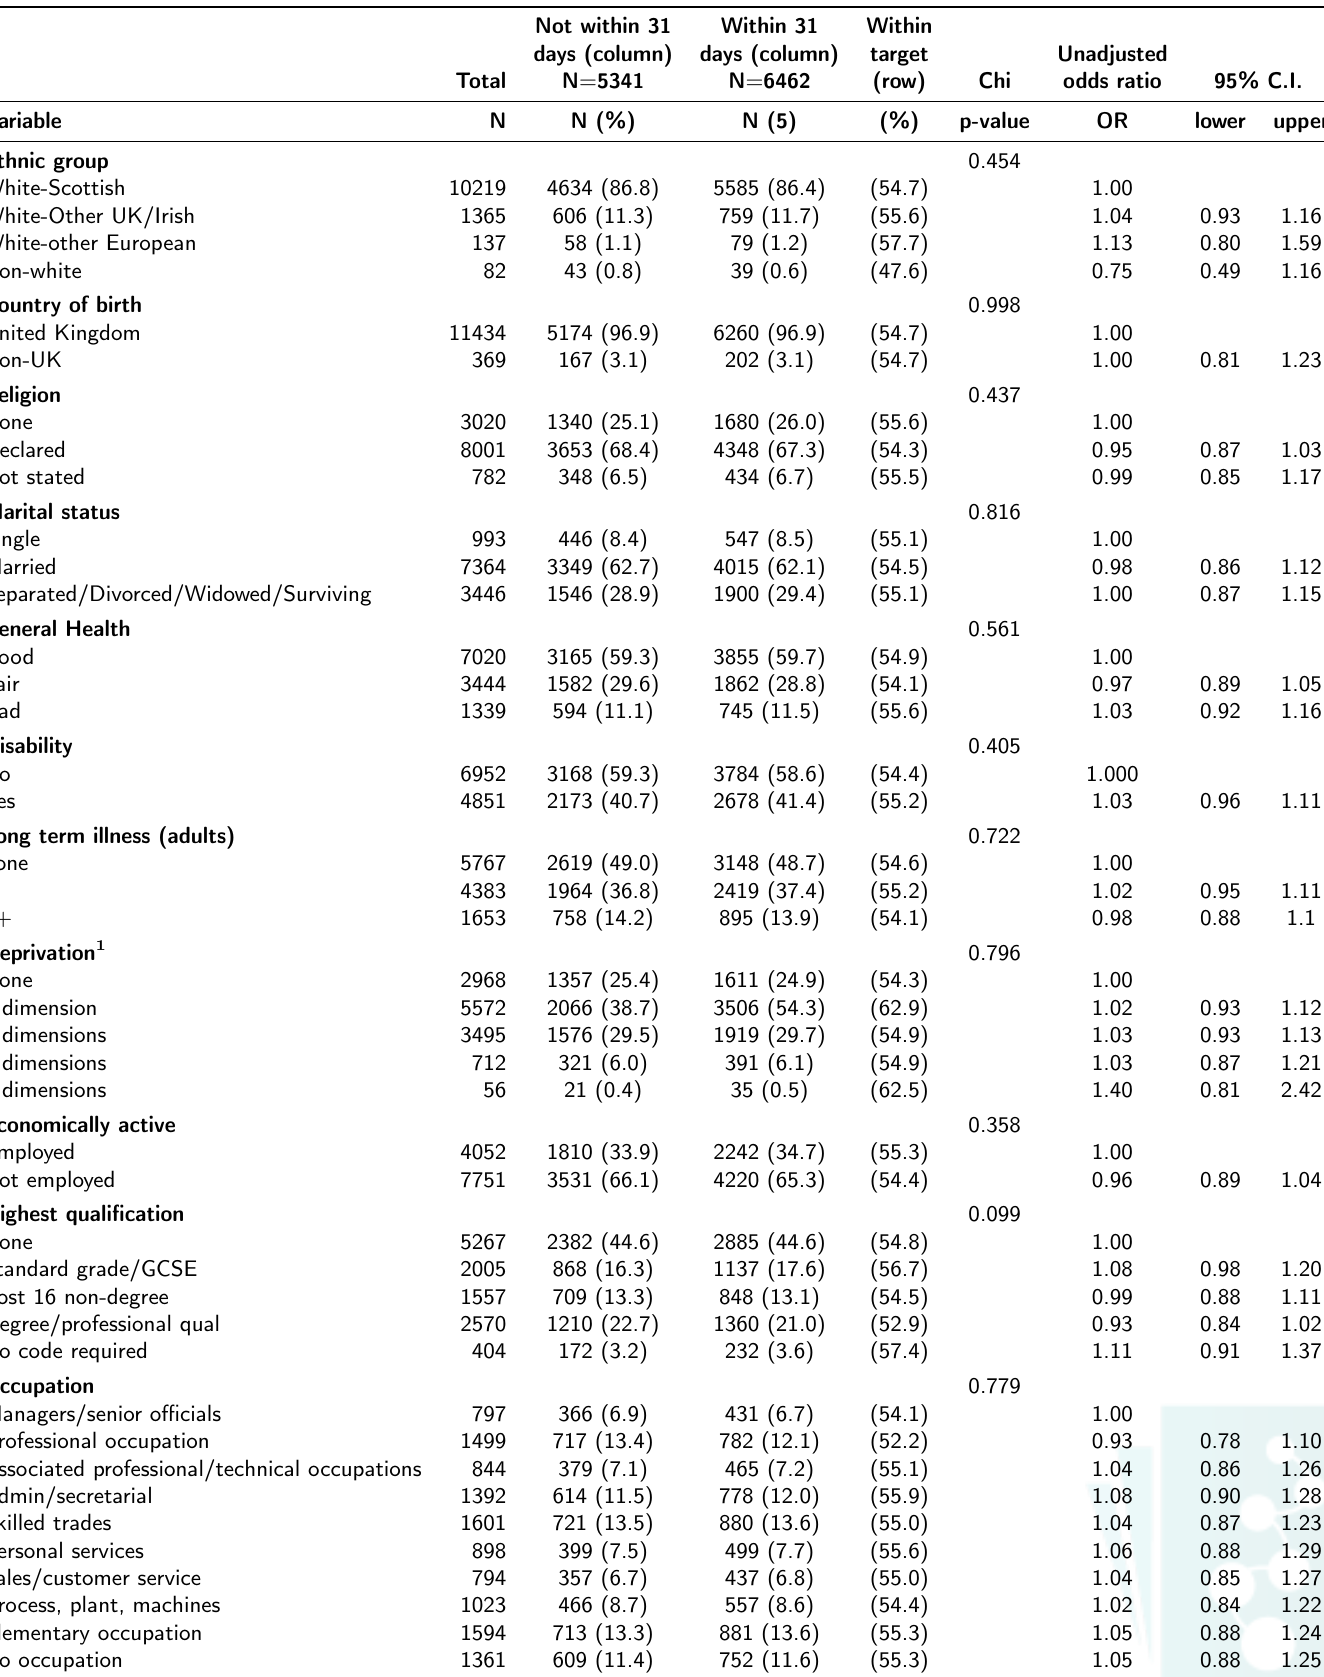
Table 4: Census characteristics by treatment within 31 days of